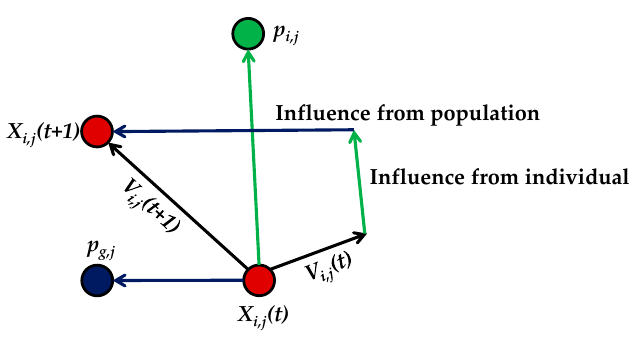
Figure 4. The schematic diagram of particle swarm optimization (PSO) algorithm.